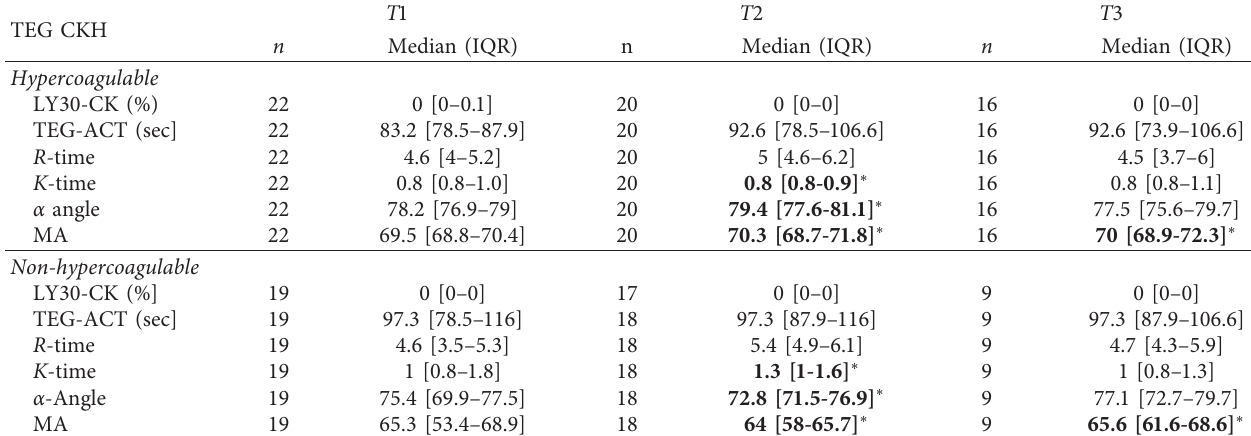
Table 1: Changes in the TEG and anti-Xa levels between admission and at day 10/resolution.